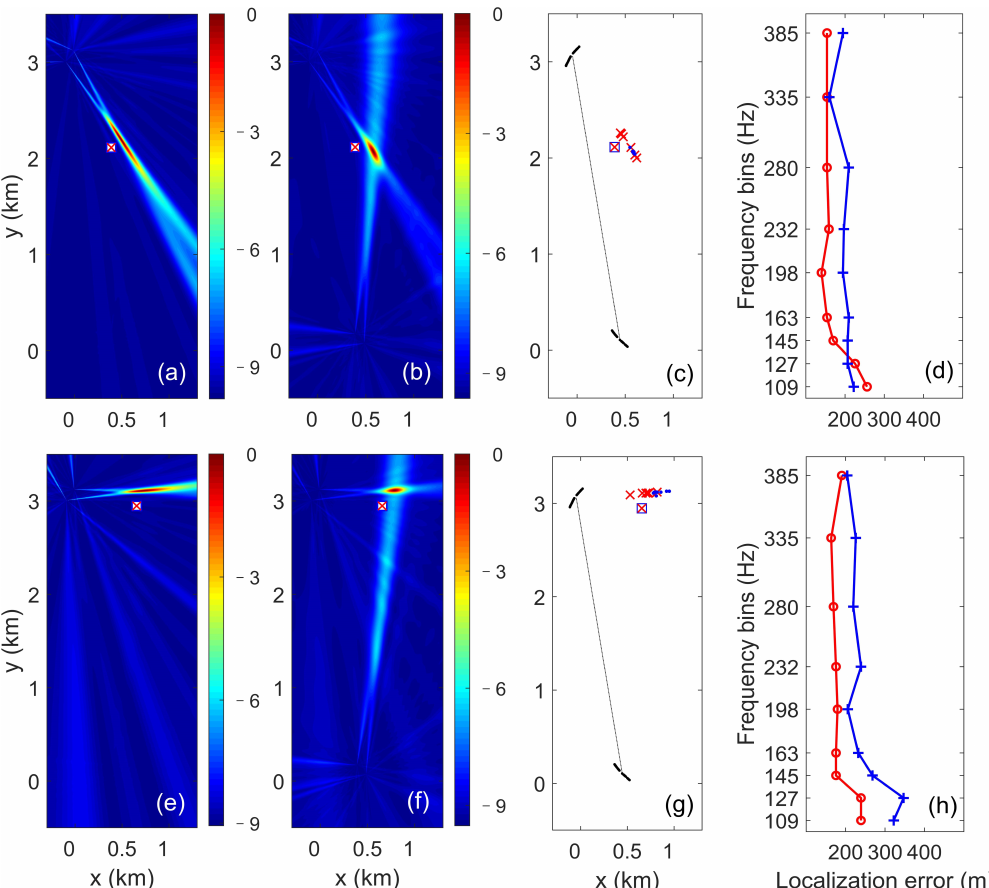
Figure 7. (Color online) Demonstration of typical behavior of GMA and N-MUSIC in section 2. Results are with 198 Hz at segment 8 (first row) and segment 14 (second row), respectively. ( a , e ) Spatial spectra of GMA. ( b , f ) Spatial spectra of N-MUSIC. ( c , g ) Position estimates of GMA (red symbols) and N-MUSIC (blue symbols). True source position is indicated by red cross symbol inside the square. ( d , h ) Estimation results of GMA (solid red line with red circles) and N-MUSIC (solid blue line with plus symbols).